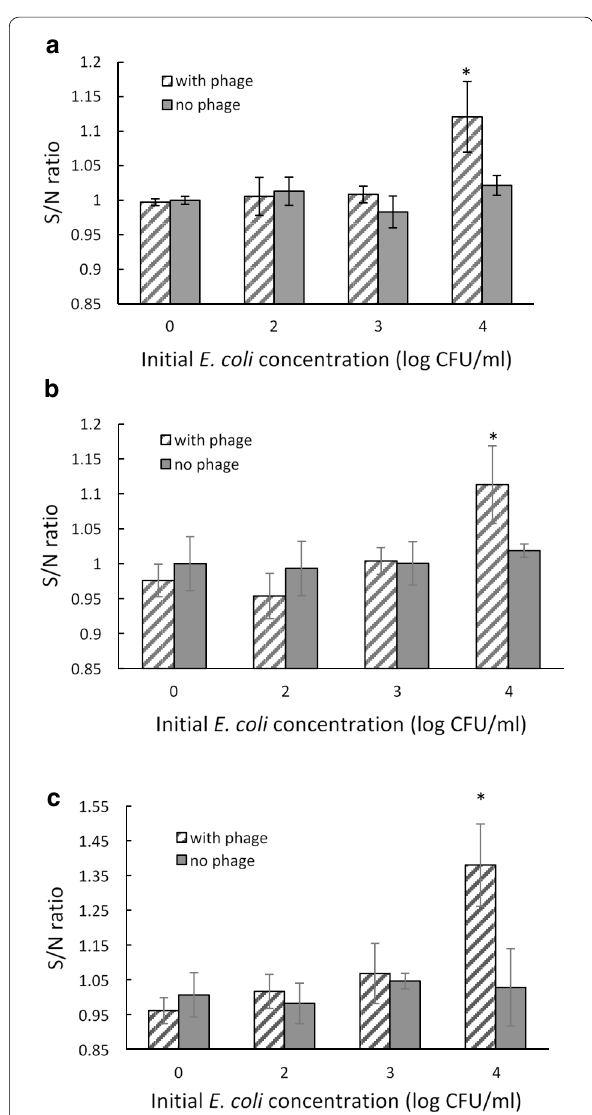
Fig. 7 Signal to noise ratio of Alkaline phosphatase over-expressed by E. coli BL21 after 4 h of enrichment in TSB ( a ), coconut water ( b ), and apple juice ( c ) after infection with phage T7-ALP for 30 min. Asterisk indicates significant difference (P < 0.05) from negative control. Error bars indicate standard deviation of ±